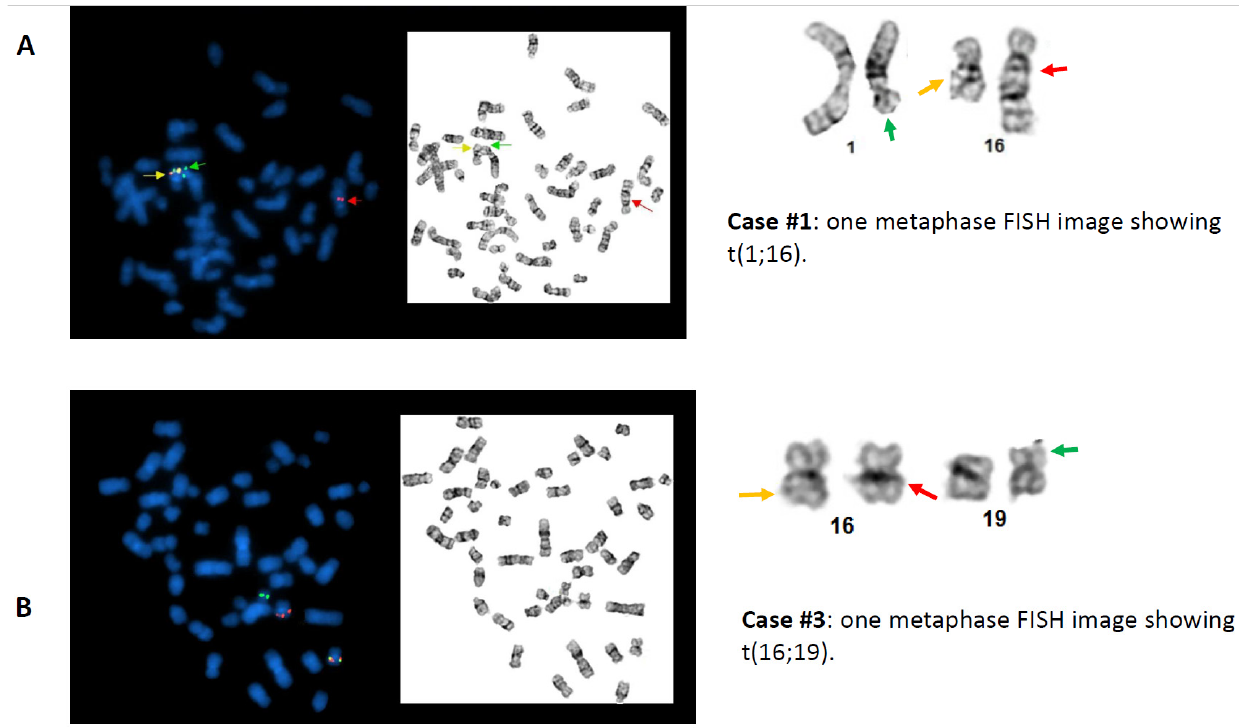
Figure 2. CBFB BAP FISH demonstrated that 3 ′ CBFB signal (green) was translocated on an abnormal chromosome 1 ( A) . Case #1 and an abnormal chromosome 19 ( B) . Case #3, respectively. From left to right: metaphase FISH image with DAPI; inverted metaphase FISH image to show chromosome morphology; affected chromosomes and their normal homologs. Red: 5 ′ CBFB ; Green: 3 ′ CBFB; Fusion (yellow) : intact CBFB.